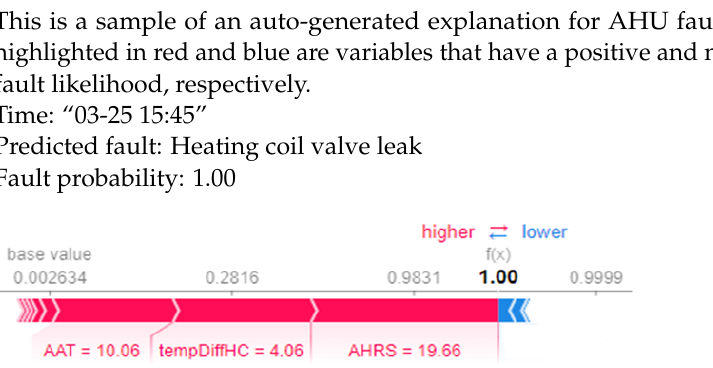
Figure A1. Heating coil valve leakage. Standard SHAP plot for individual explanations. Based on the above plot, please rate , on a scale of 1 to 10, how important these criteria are in helping to understand whether a fault explanation actually represents a fault.